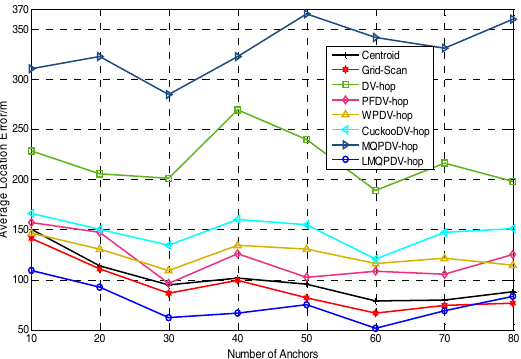
Figure 7. The effect of the number of anchors on error for WSN#1.